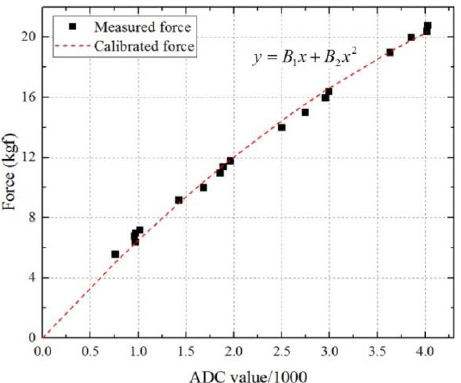
Figure 9. Calibration curve of the FSR in the range of 0 to 20 kgf. The ADC values divided by 1000 were fitted with a second order polynomial. The coefficients of this curve, B 1 and B 2 , are 6.97 and -0.47, respectively.